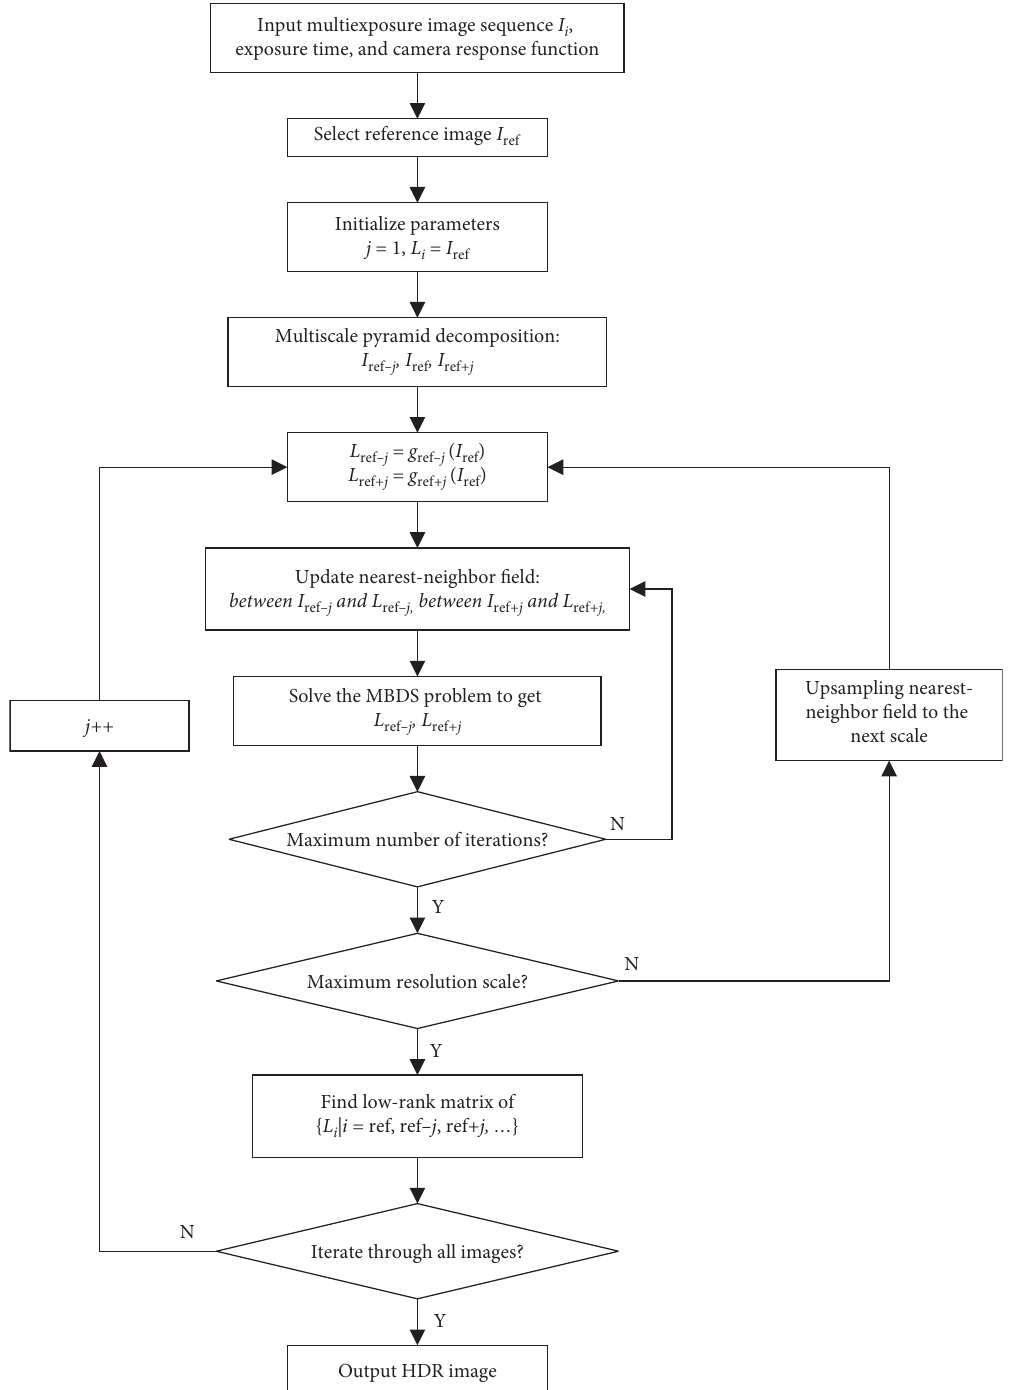
Figure 4: Process of low-rank